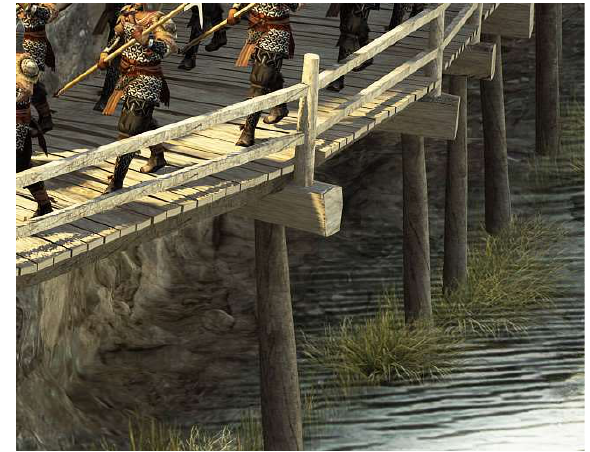
Figure 15. Part of Structure style of the Chiya Plank Road.